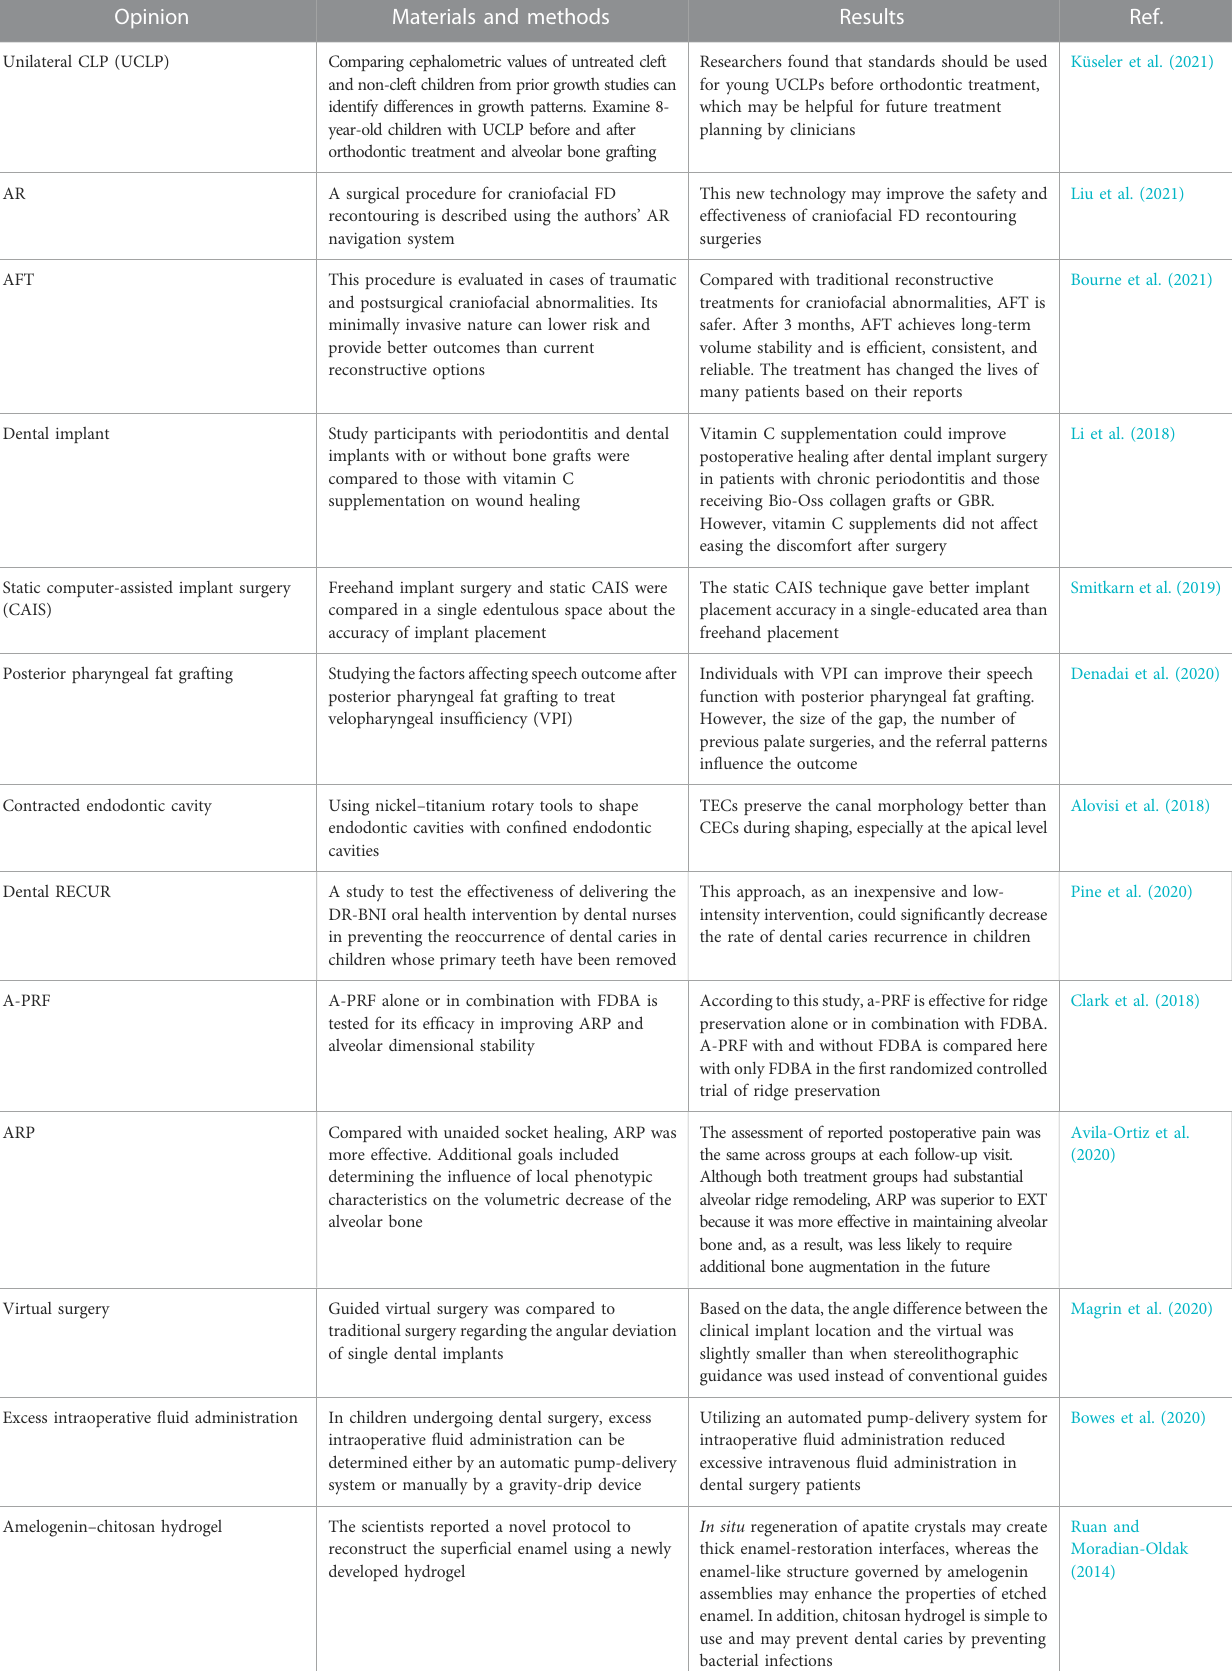
TABLE 1 Surgical therapy in craniofacial